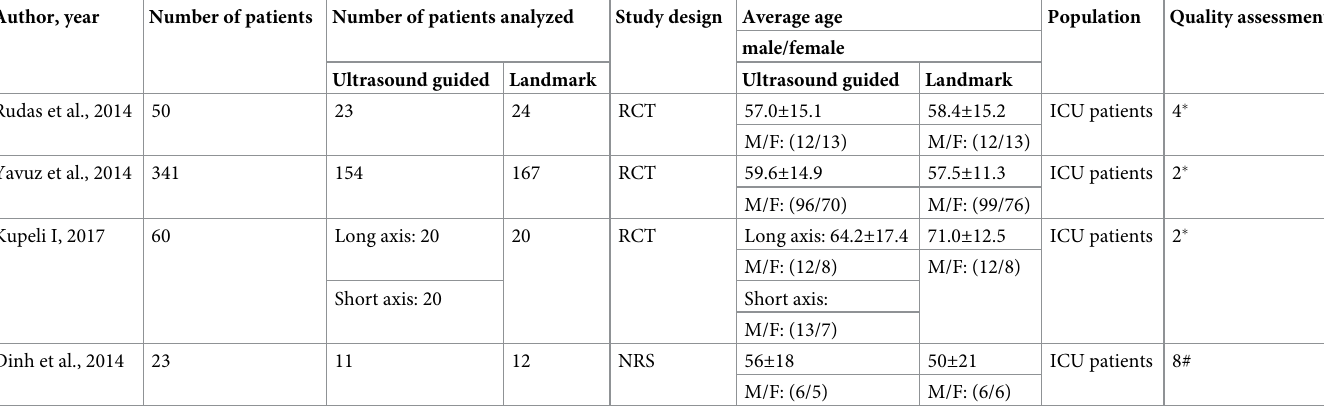
real-time long-axis, real-time short-axis, and traditional landmark techniques [26]. One study compared only the real-time long-axis UGT method with the LT method [27]. The Jadad scores of the included RCTs were between two and four points. The randomization and blind- ing methods were recorded in Rudas’s study [24], but they were not recorded in the other two RCTs [25, 26]. In Dinh’s study [27], the Newcastle-Ottawa Quality Assessment scale was eight points, and the study controls for additional factors were not clearly reported. The patient characteristics and study methodology of the included trials are listed in Tables 1 and 2, while Table 3 summarizes the UGT and LT procedures. Table 1. Characteristics of included studies comparing ultrasound-guided with landmark percutaneous dilatational tracheostomy. Author,